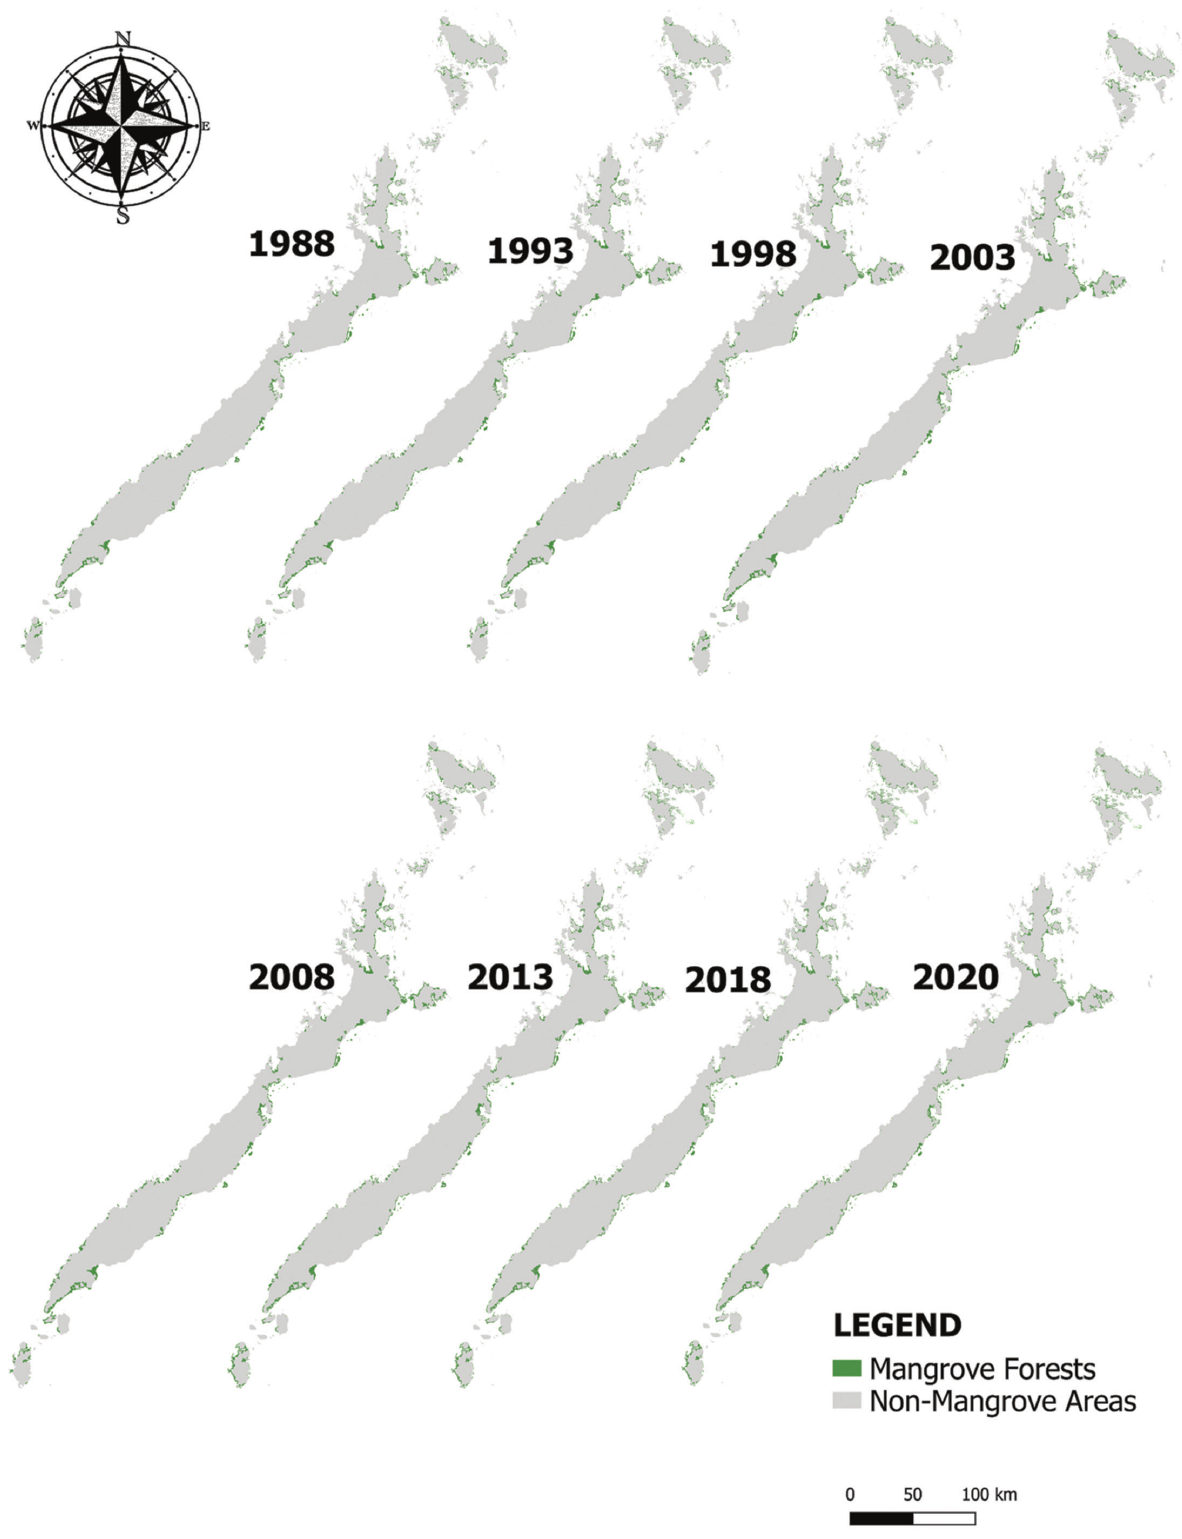
The classified maps from 1988 to 2020 showed that the largest area of mangroves in Palawan was recorded in 2020 (60,033.8 ha) while the year 1998 (48,745.3 ha) had the least extent (Fig. 3). Spatiotemporal distribution of The lower total area calculated for 1998 is likely due to misclassification as a result of minor cloud mangroves in Palawan in a span of patches, especially in the northern part of Palawan. Our estimate for this year, however, does not 32 years from 1988 to deviate too far from the estimates in 1993 (50,045.3 ha) and 2003 (52,961.5), respectively.